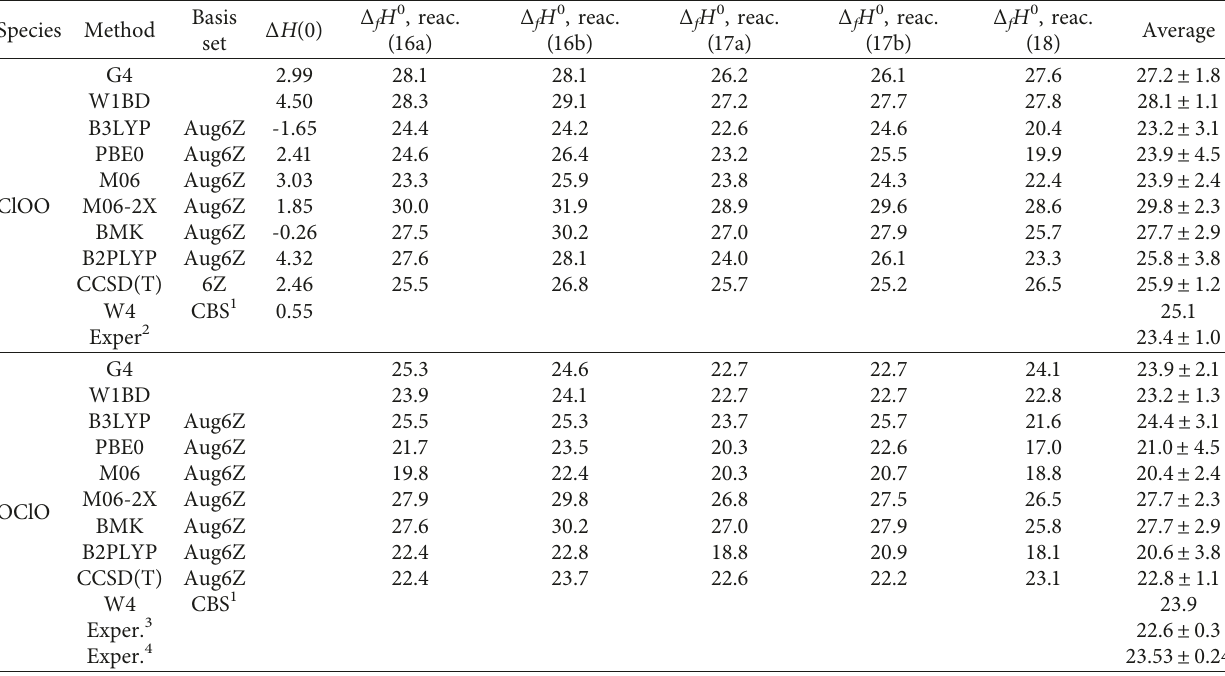
Table 2: Relative energies (in kcal/mol) of the isomers of ClO 2 and enthalpies of formation at 298K determined from reactions (16)–(18). Basis Species Method